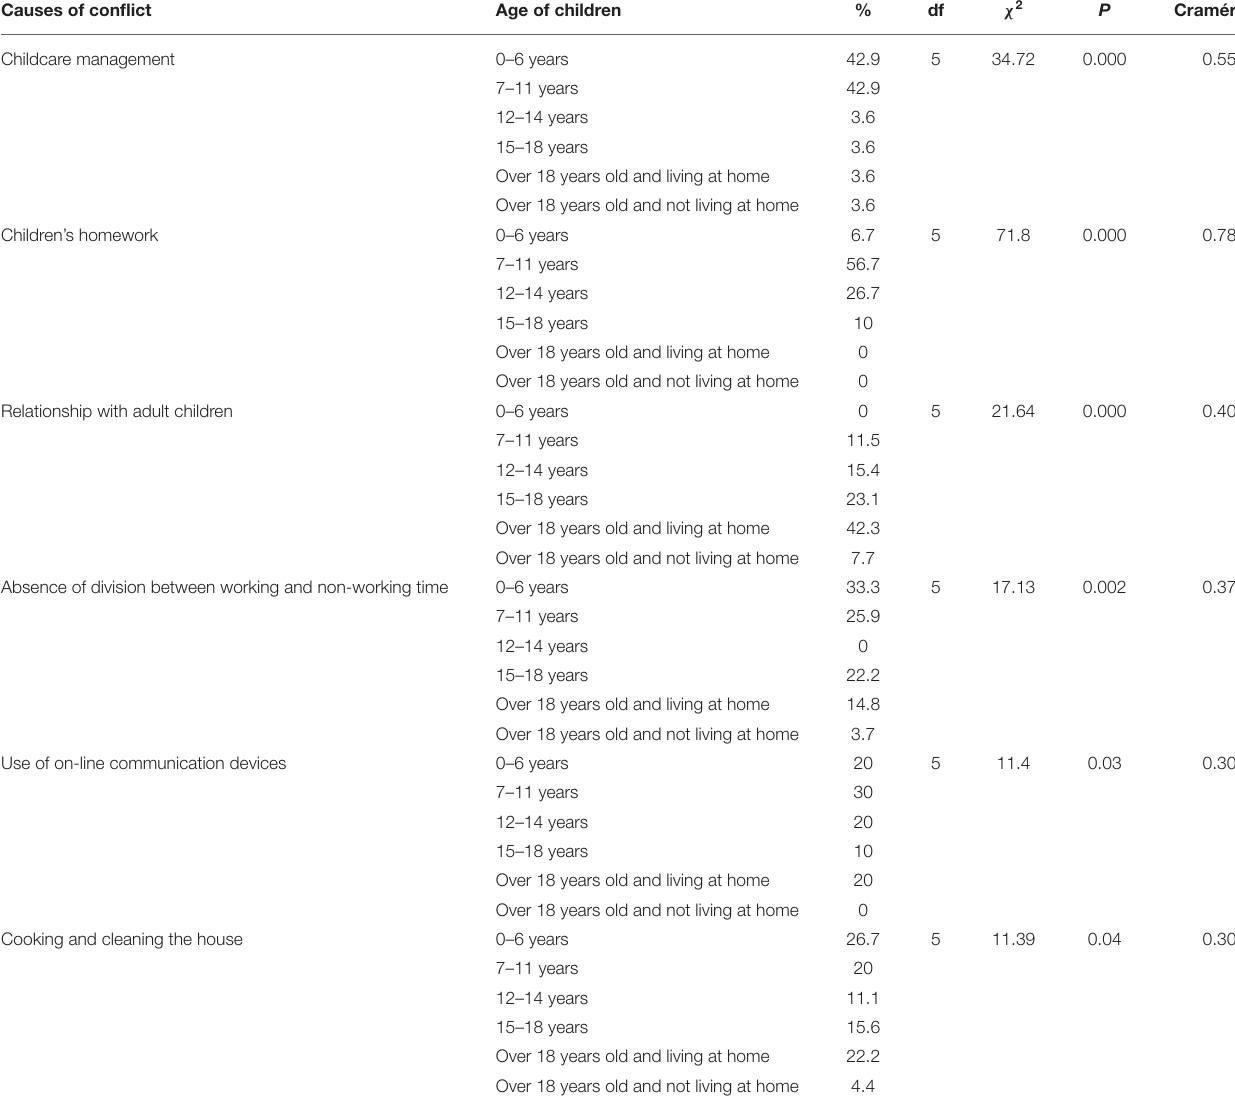
TABLE 1 | Causes of conflict and age of children. Causes of conflict